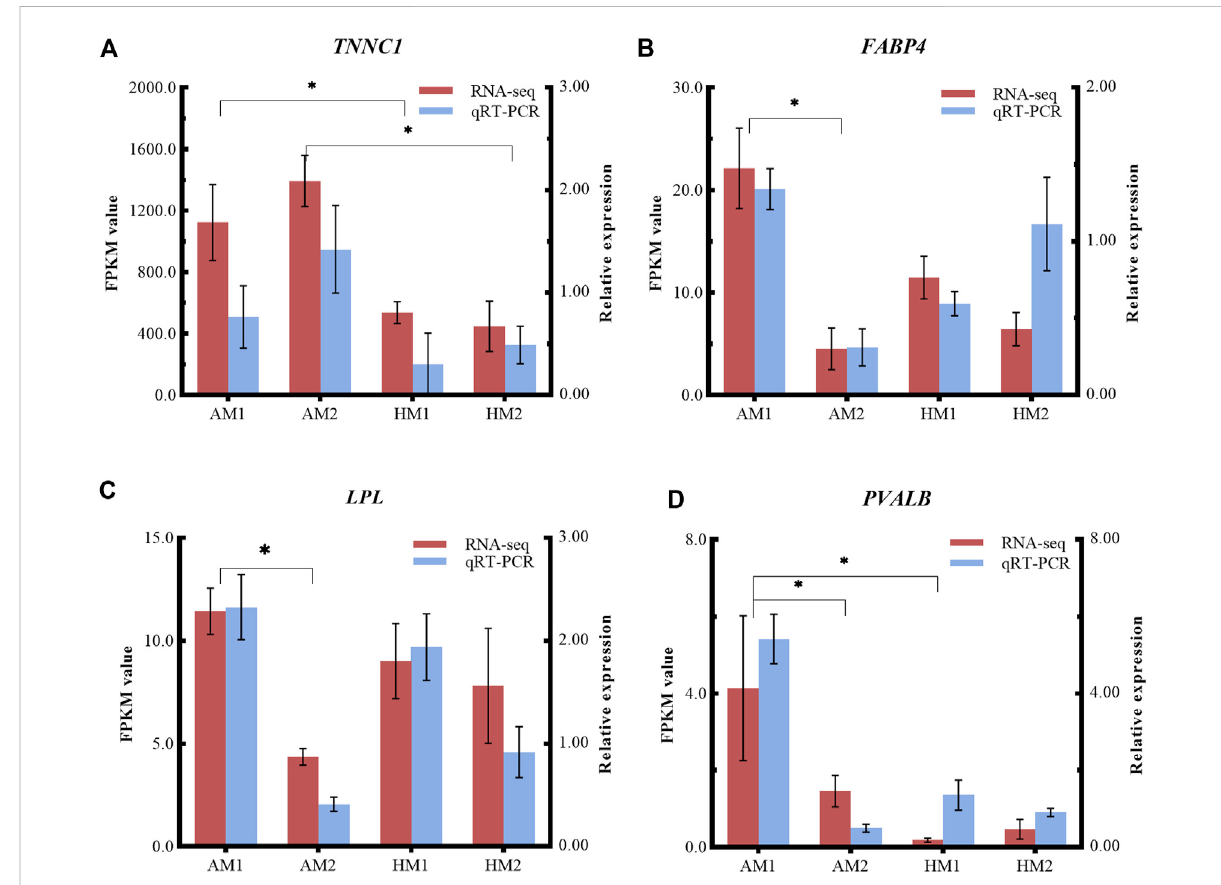
FIGURE 6 Relativeexpressionsandfragmentsperkilobaseofexonmodelpermillionreadsmapped(FPKM)valuesfromqRT-PCRandRNA-seq.They-axis on the left and red bars represent the FPKM values of four genes from RNA sequencing. The y-axis on the right and blue bars represent the relative expressions offourgenesfromRNA-seq.Thex-axis representsfourgroupsinthisstudy: (A) TNNC1; (B) FABP4; (C) LPL;and (D) PVALB.AM1:muscle tissue of Altay lambs at − 5 ° C; AM2: muscle tissue of Altay lambs at 20 ° C; HM1: muscle tissue of Hu lambs at − 5 ° C; HM2: muscle tissue of Hu lambs at 20 °